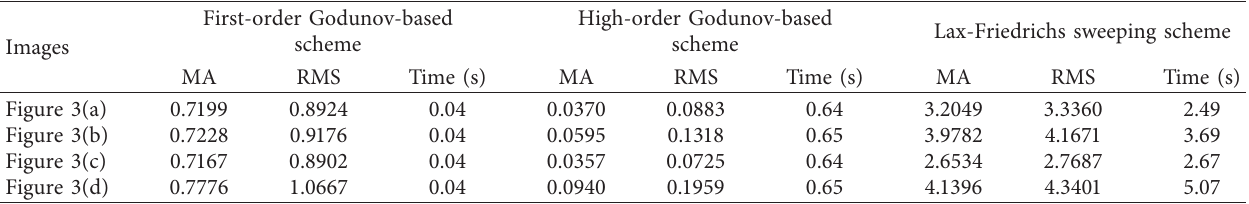
Table 2: Quantitative comparisons of schemes for the synthetic ball images.